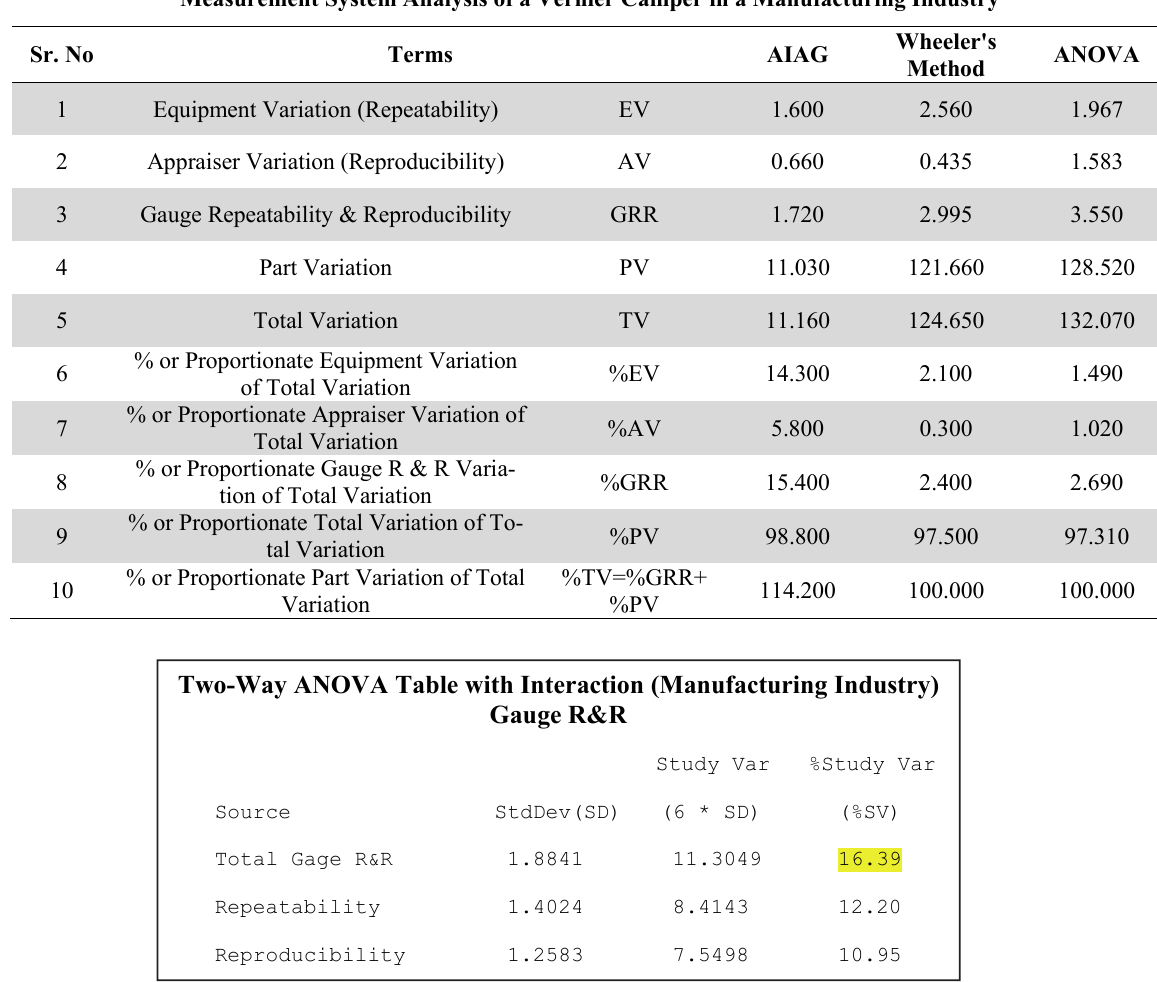
Fig. 2. ANOVA Calculation by Minitab (Manufacturing